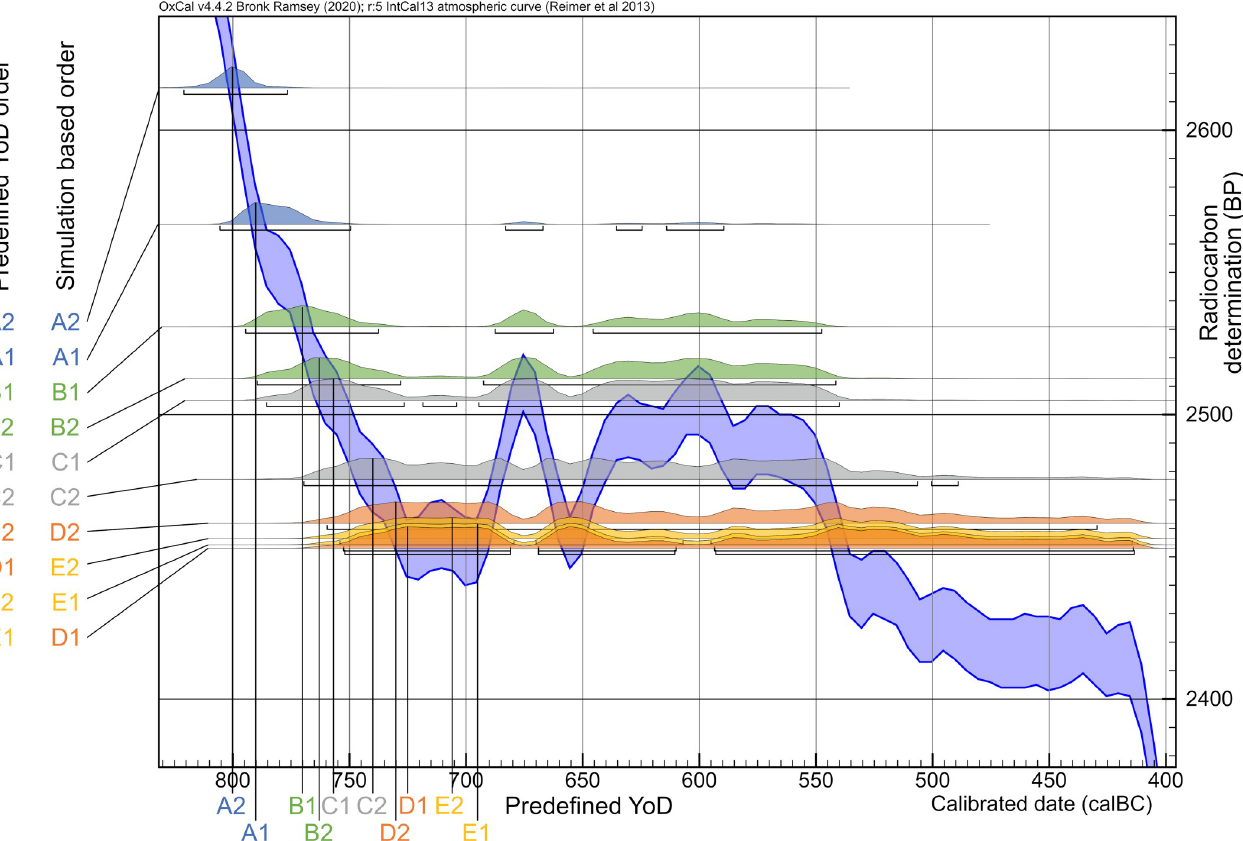
Fig 16. Closeup of calibrated radiocarbon dates of the anchor point model. Unmodelled 14 C ages with 25 years uncertainty right before (individual A2) and on the Hallstatt plateau section (compare Fig 4A) of the calibration curve (IntCal13) show the inversion of calibrated dates (2-sigma).